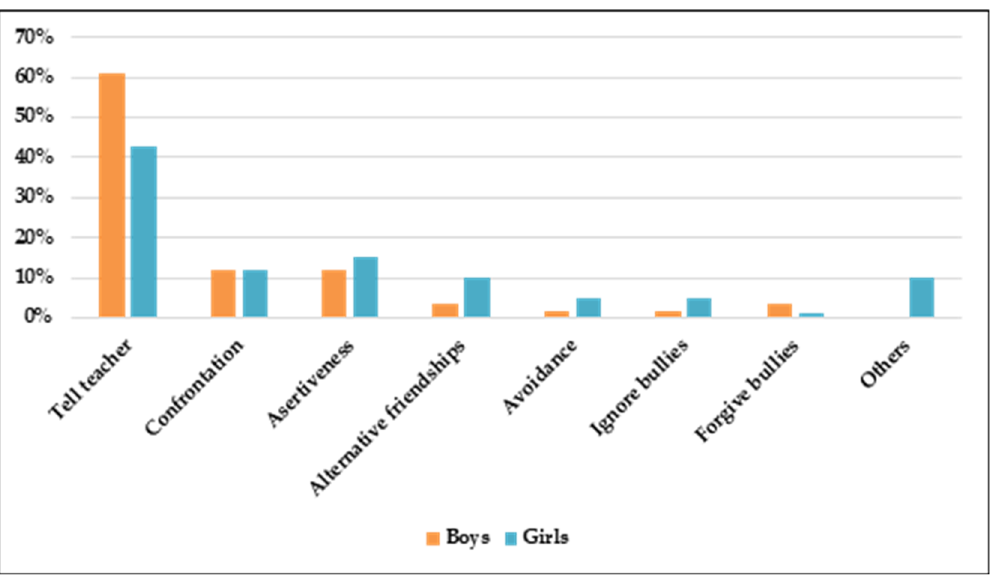
Figure 7. Coping strategies per gender.